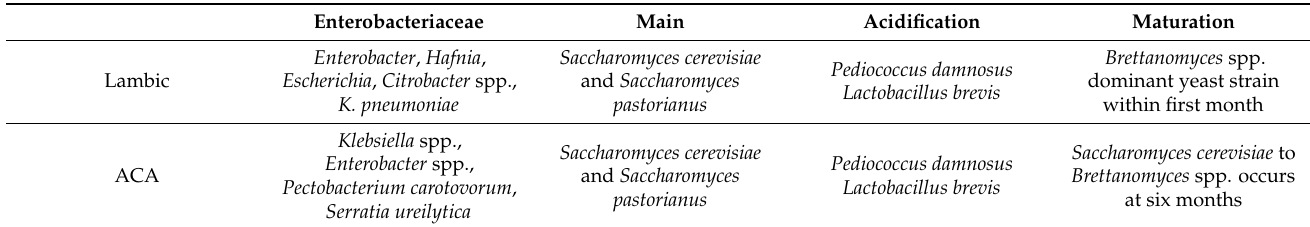
Table 1. Microbes found during each stage of the Fermentation